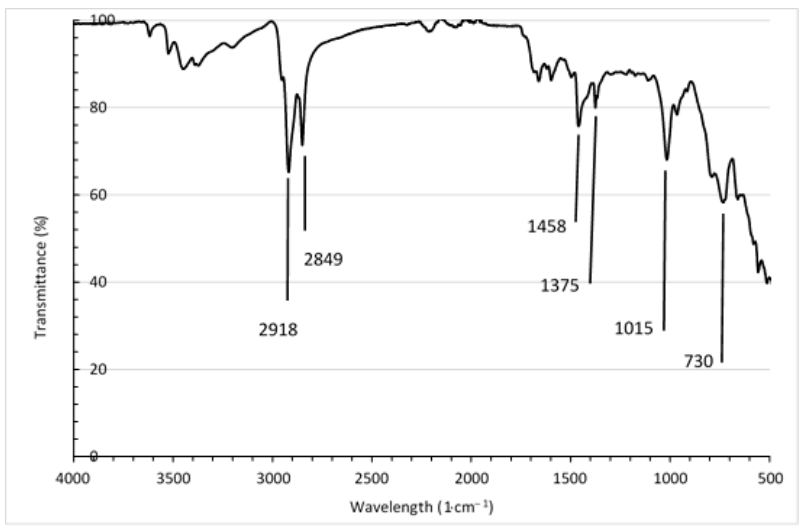
Figure 1. ATR-FTIR spectrum of waste rubber foam.